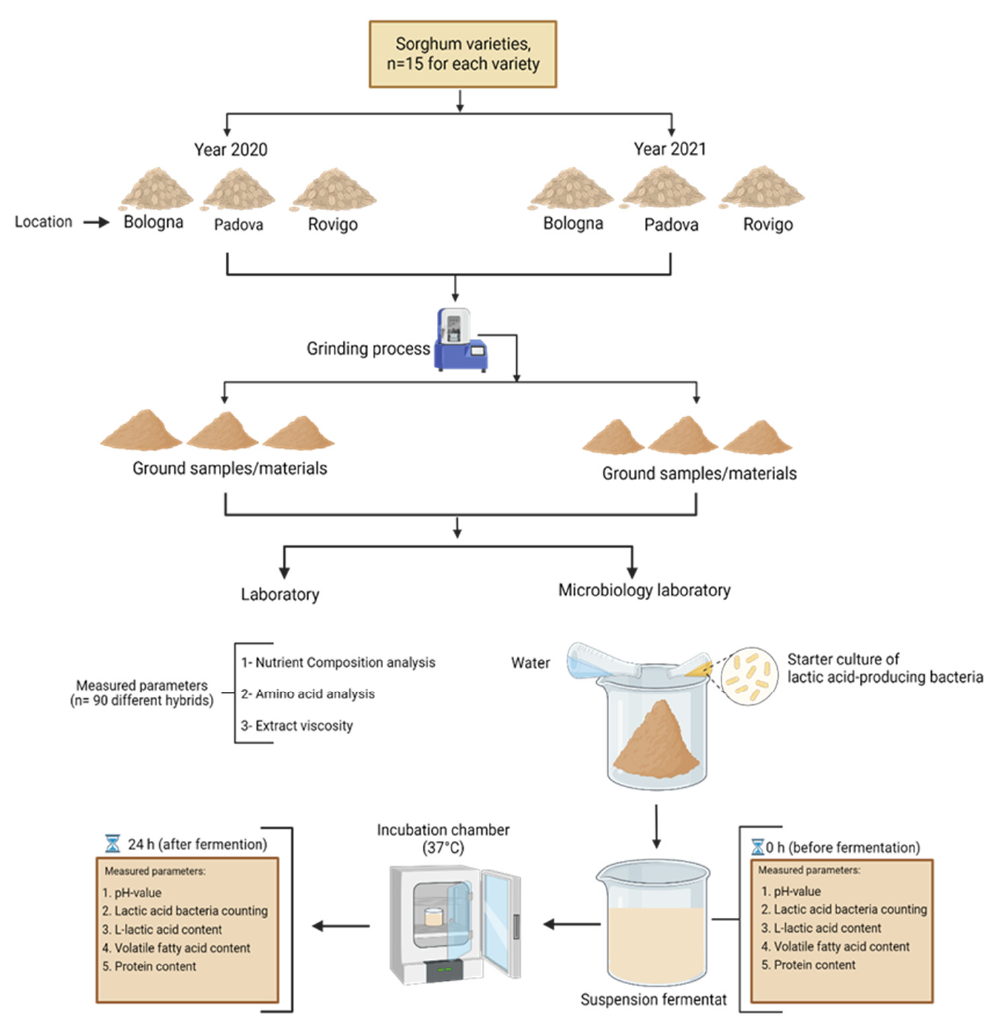
Figure 1. Experimental design for determining nutrient composition and for the fermentation process of sorghum (figure was created with BioRender.com on 25 May